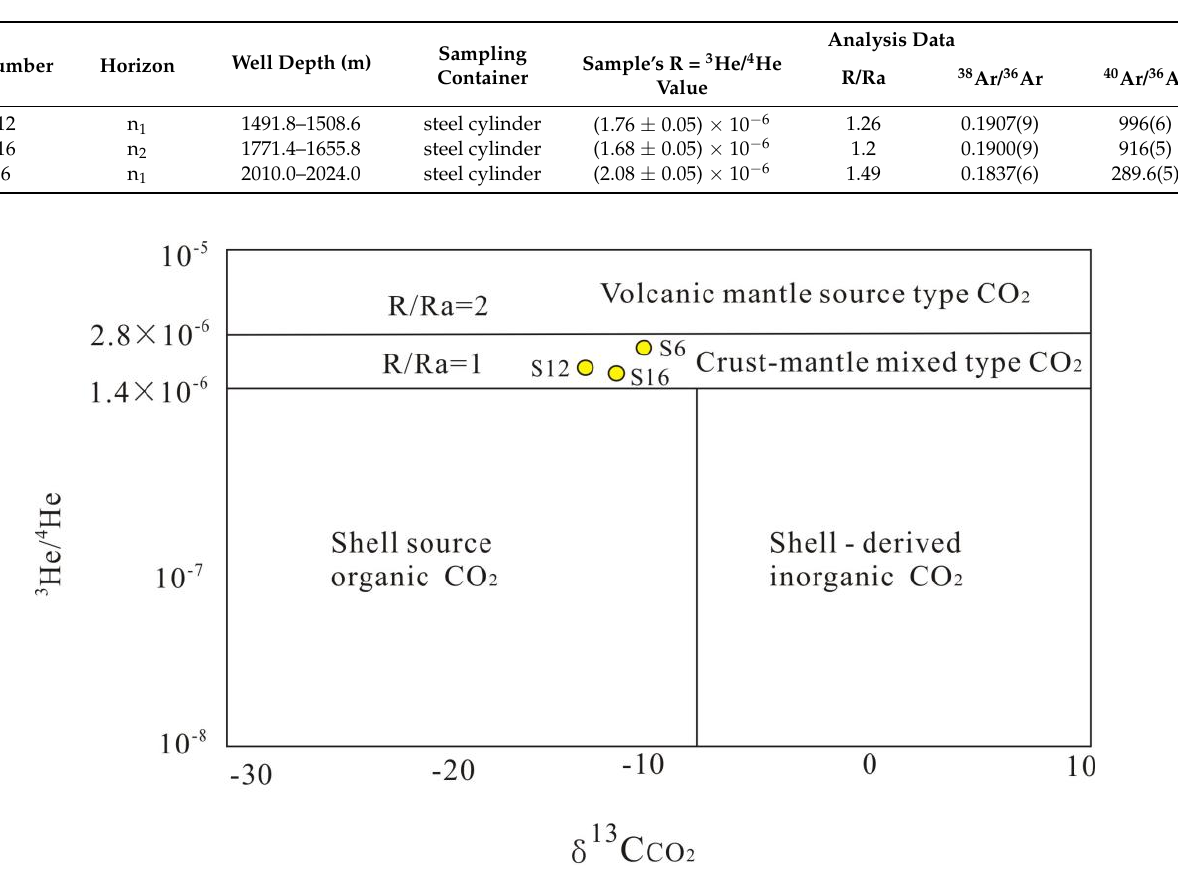
Table 3. The natural gas He and Ar isotope test result in Hailar Basin.